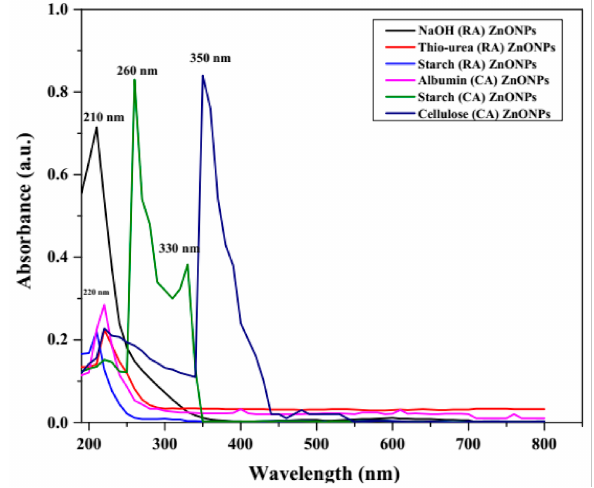
Figure 2. Variable UV-Vis absorbance spectra of the synthesized ZnO nanoparticles. RA: reducing agent, CA: capping/complexing agent.